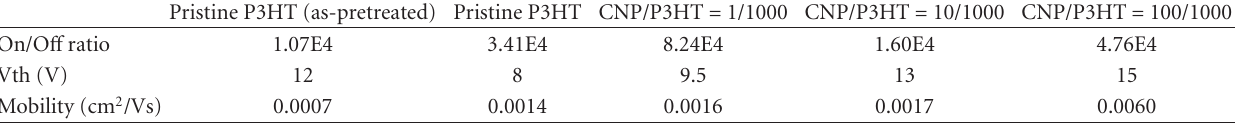
Table 1: The experiment result of di ff erent